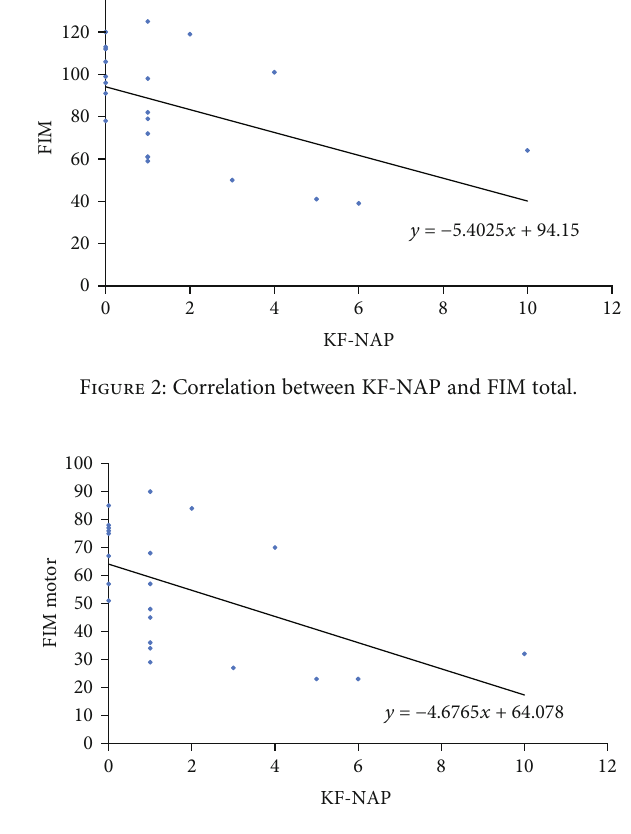
Figure 3: Correlation between KF-NAP and FIM-motor.